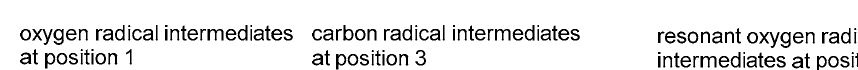
(R=CH ) in deaerated acetonitrile containing 0.1 2 3